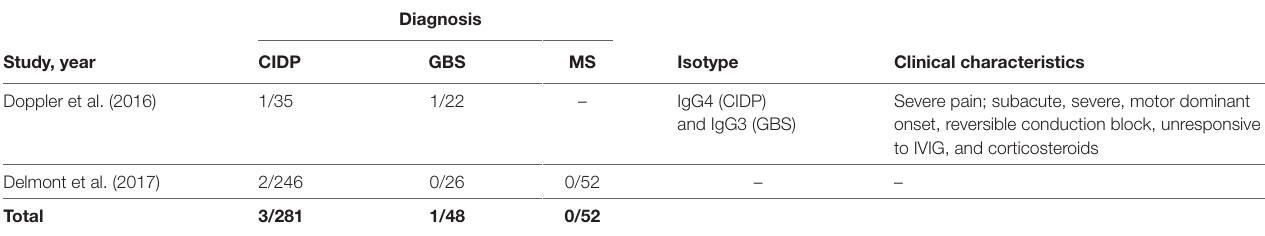
TABLe 5 | Studies that tested autoantibodies against contactin-associated protein 1.